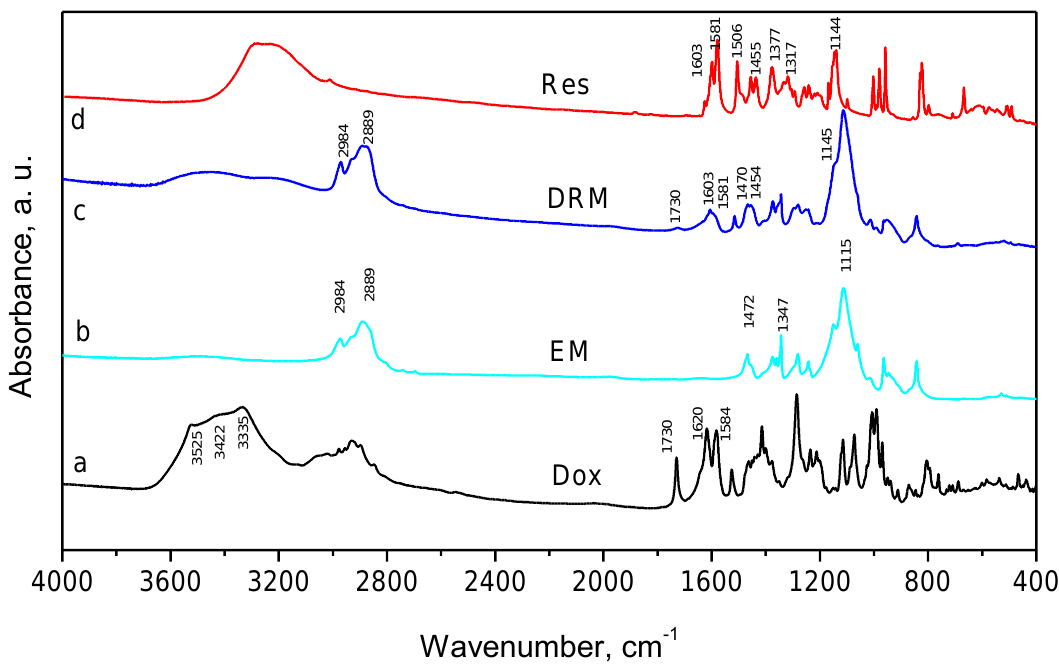
Figure 5. FTIR spectra of doxorubicin (Dox), resveratrol (Res), empty (EM) and double-loaded mi-